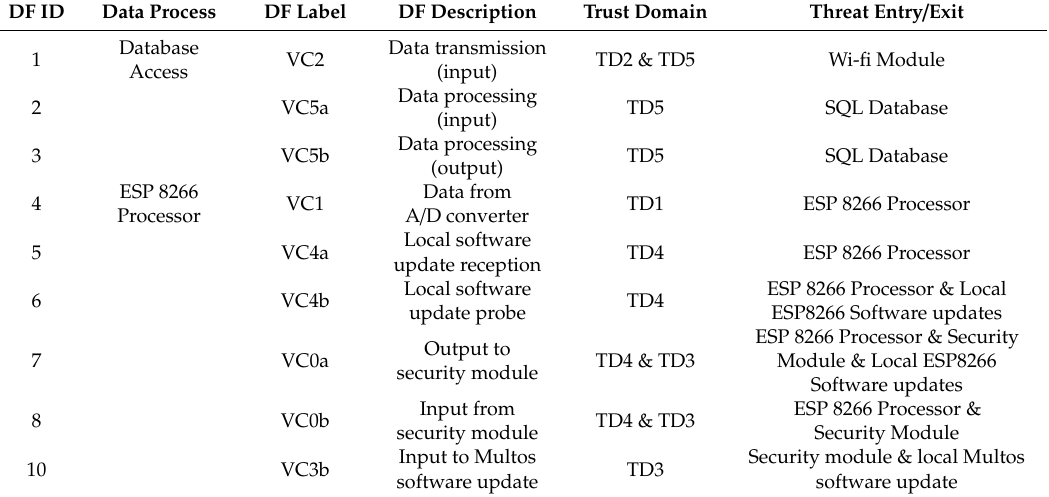
Figure 10. Daedalus Data Flow Diagram for the system without the thin security element. Table 1. Process data flow and threat entries for Daedalus